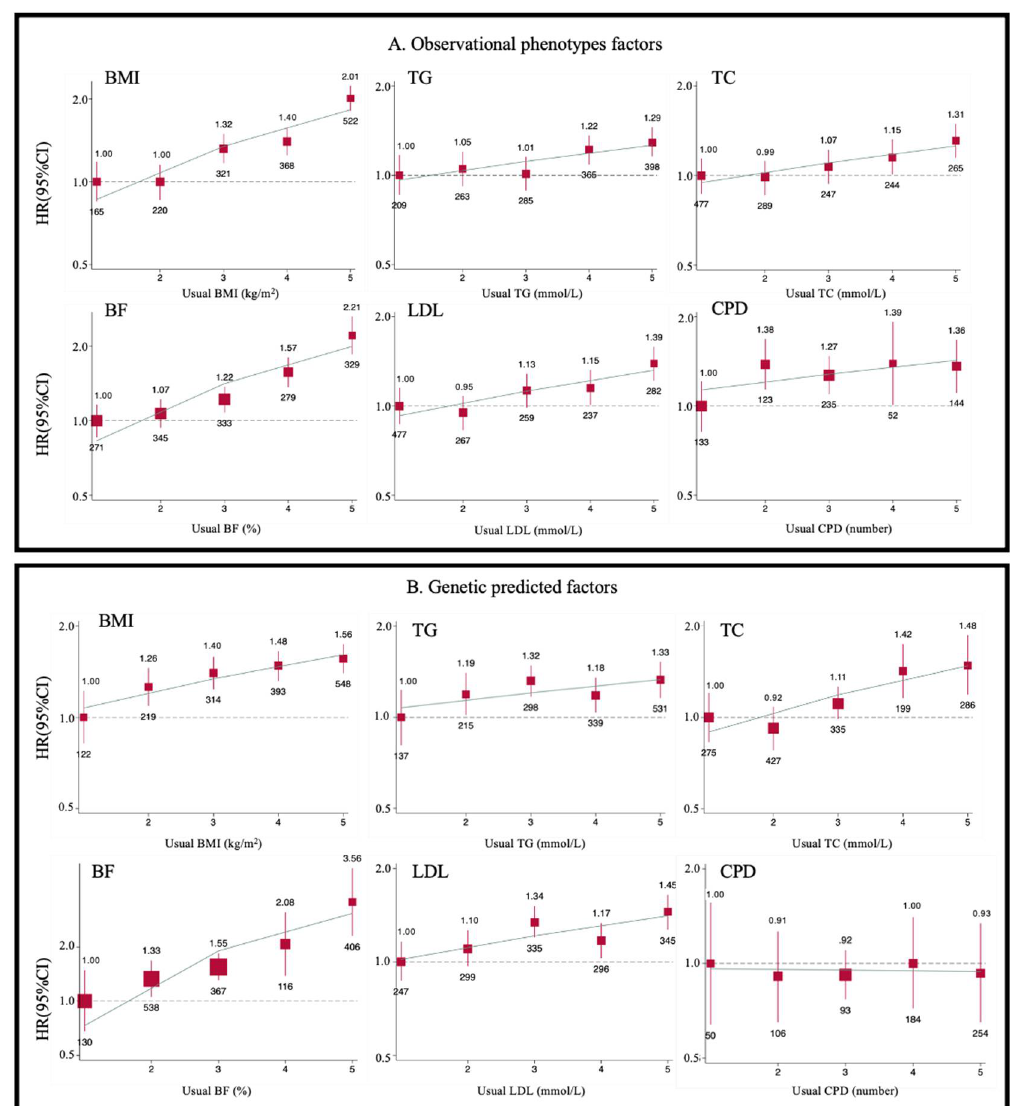
Figure 3. Adjusted HRs for risk of AVS by fifths of BMI, BF, TG, LDL, TC, and CPD in observational analysis and Mendelian randomization analysis. Cox regression was used to estimate the HRs and 95% CIs for AVS ( n = 1602) by fifths of BMI, BF, TG, LDL, TC, and CPD in observational analysis ( A ) and Mendelian randomization analysis ( B ). Each square has an area inversely proportional to the variance of the log risk in a specific group. The number below each square is the AVS case number of these factors. The line represents the slope from a weighted linear regression with the weights based on the inverse variance of the log HR.